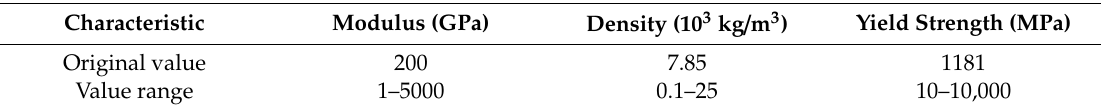
Figure 4. Extraction method of the protection efficiency of the ceramic layer. Table 4. Original values and value ranges of backing plate parameters under the semi-infinitely thick conditions.